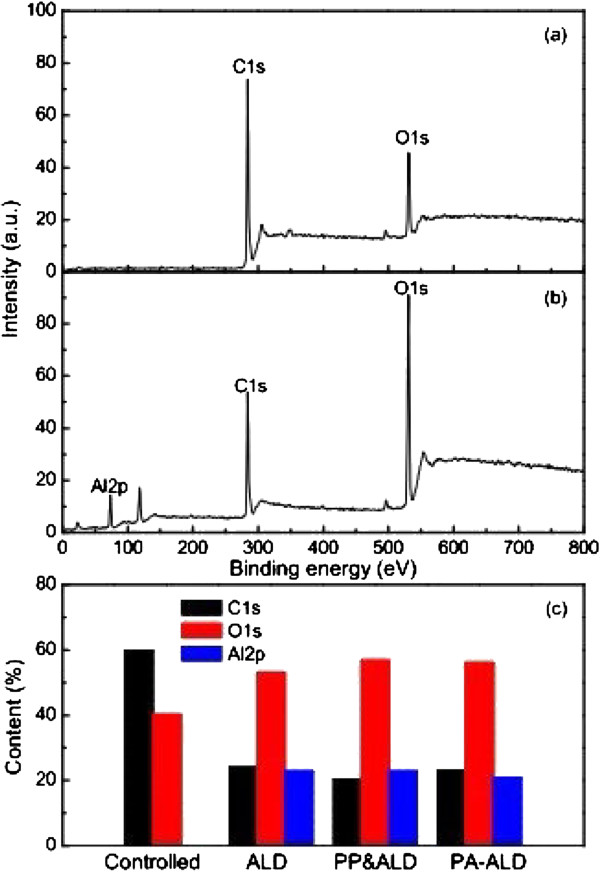
XPS spectra. (a) Uncoated PET, (b) the Al2O3-coated PET film by PA-ALD, and (c) relative elemental contents.